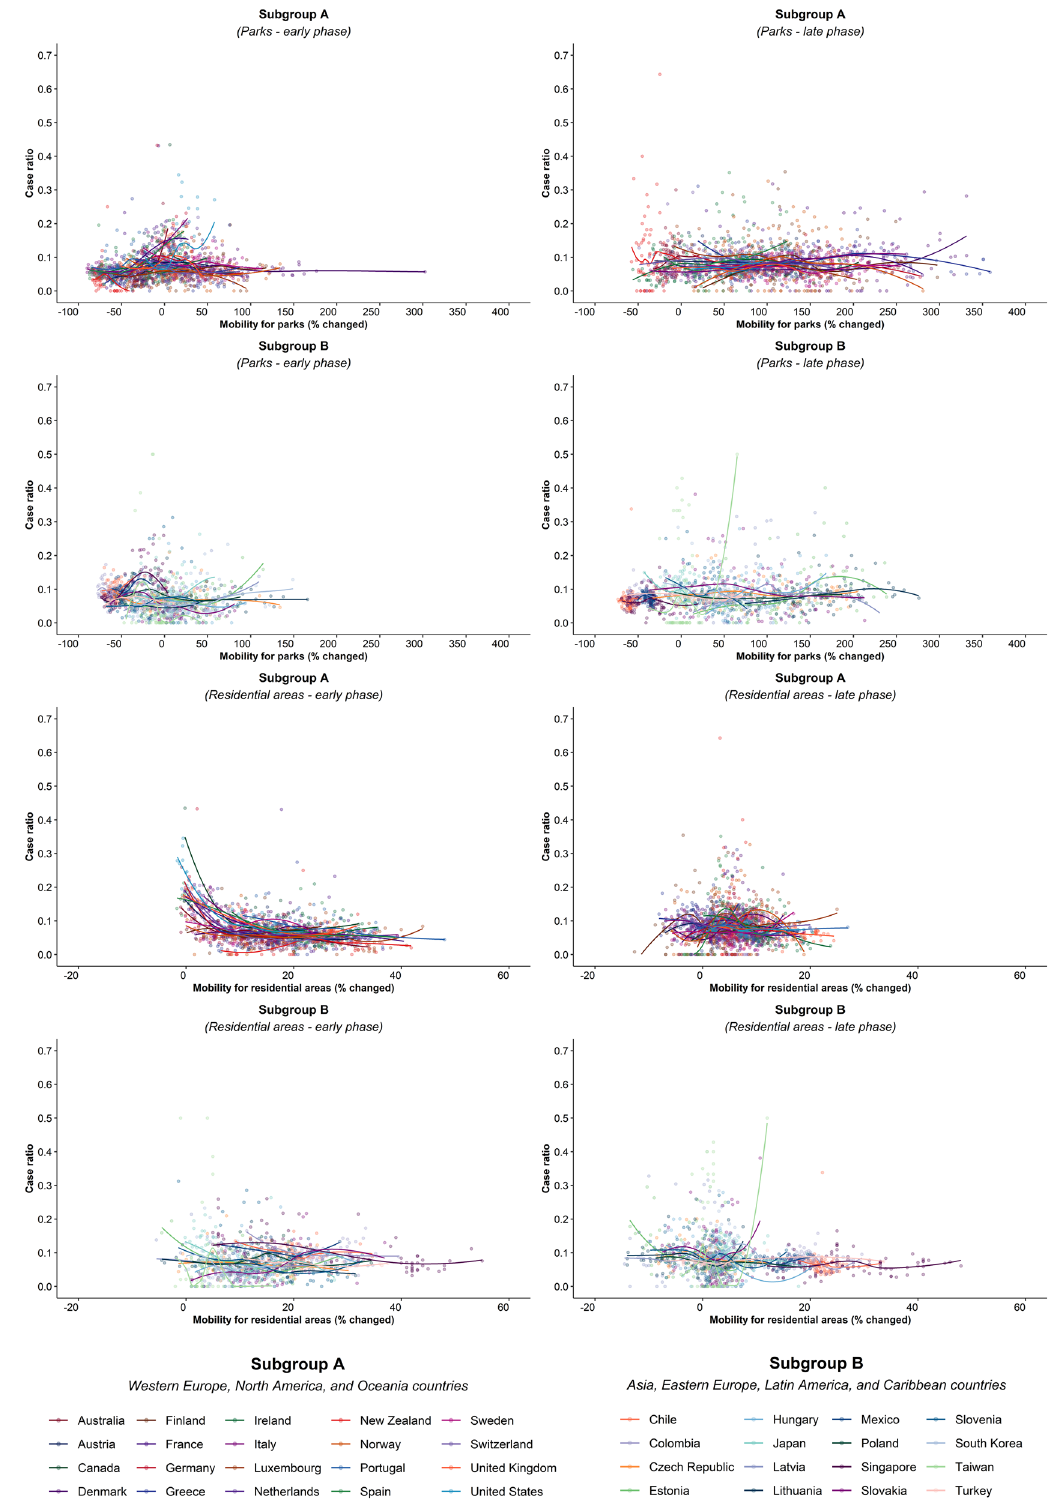
Figure 4. Association between new daily COVID-19 case ratio and mobility changes for 36 countries, early and late phase, for parks and residential areas. Footnote 1. Pandemic phase was defined for each country by the median of the date when the 100th case was detected to the end of the study period: early phase for the period before the median date and late phase for the period after the median